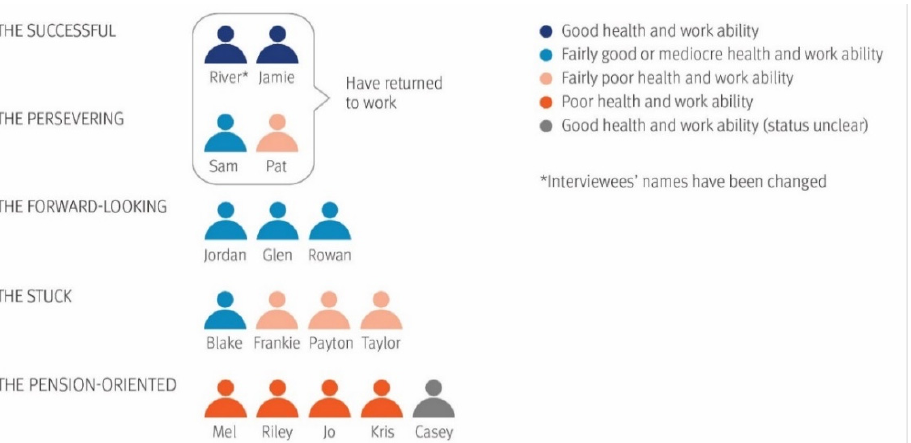
Figure 1. Interviewees’ perceived health and work ability.